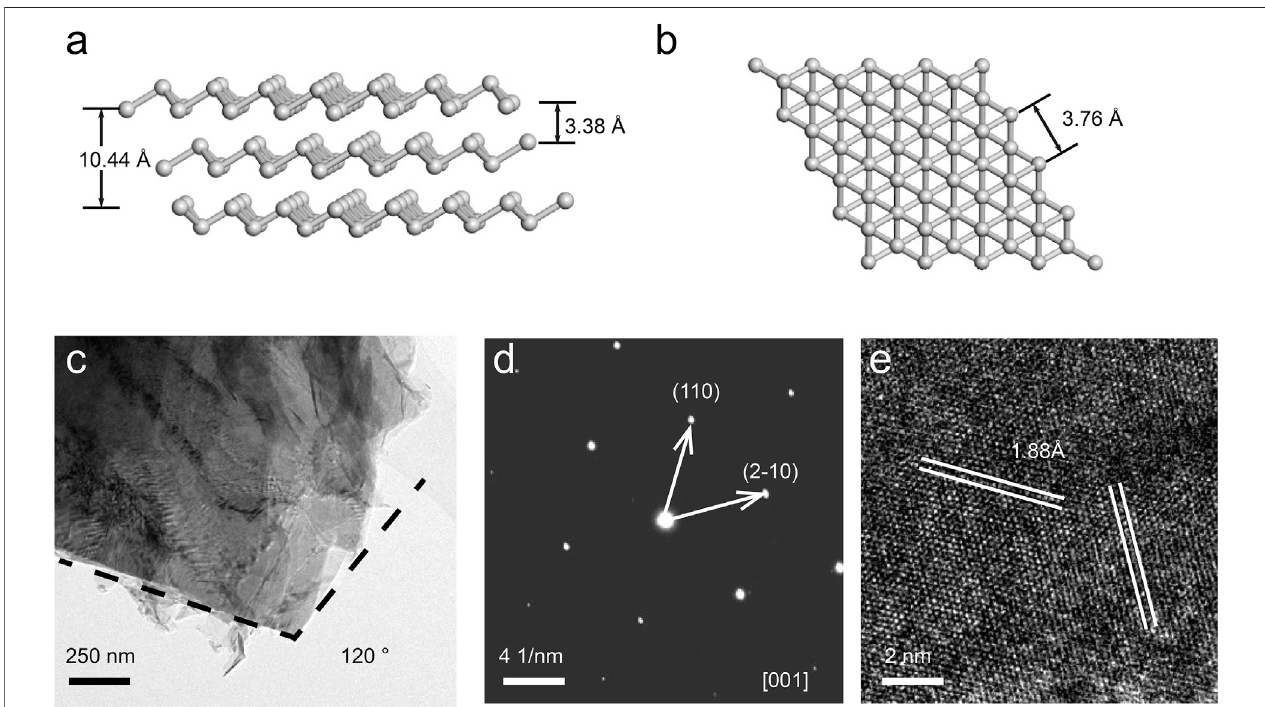
FIGURE2| Crystalstructureofthe β -phasearsenic fl akes. (A) Buckledhoneycombstructureof β -As. (B) Topviewofthebuckledarsenene. (C) Themorphologyof β -As nano fl ake at low magni fi cation. (D) The selected area electron diffraction (SAED) pattern. (E) The high-resolution TEM (HRTEM) image of a representative β -As nano fl